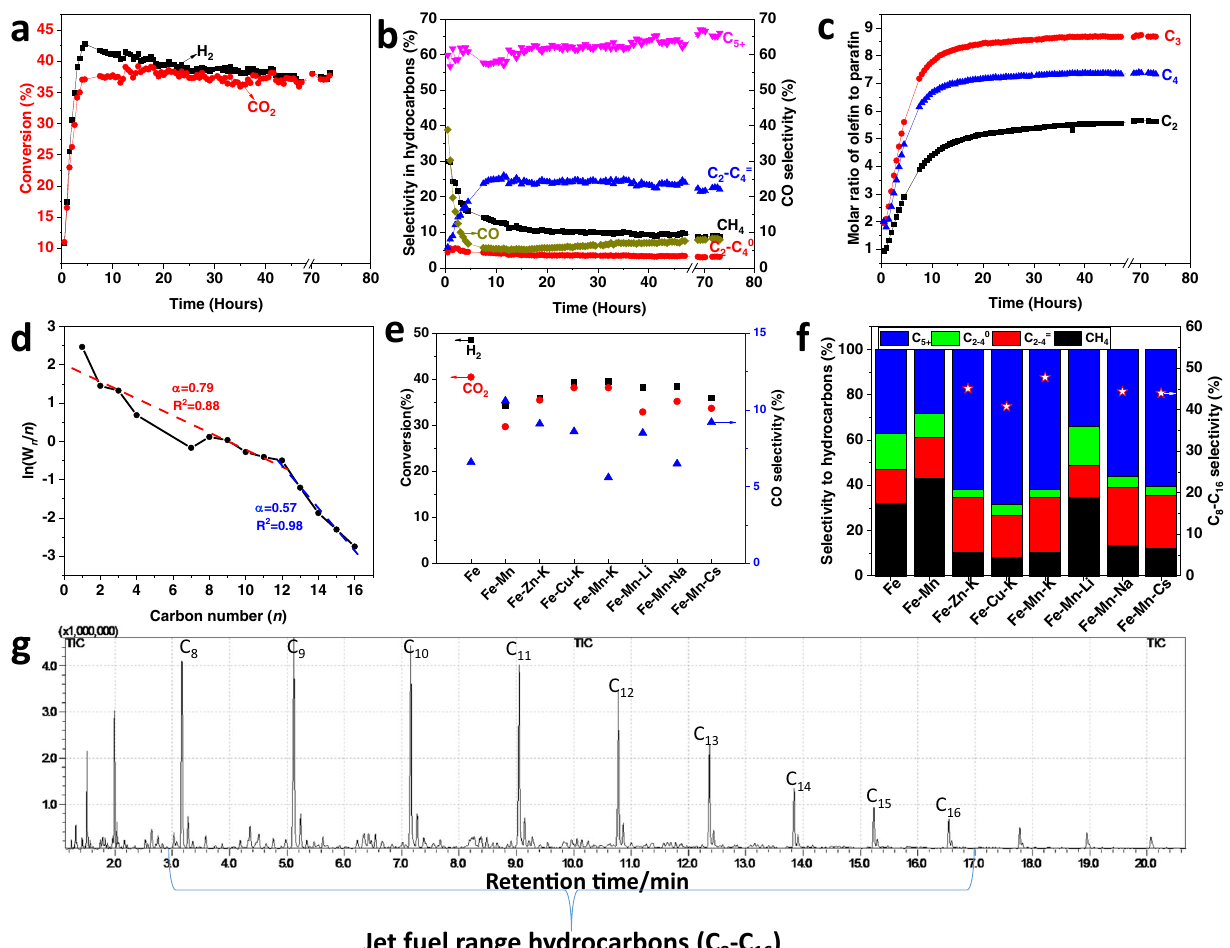
Fig. 1 Catalyst performance for the hydrogenation of CO 2 using a Fe – Mn – K catalyst. a % conversion of CO 2 and H 2 as a function of reaction time for the hydrogenation of CO 2. b Selectivity of various hydrocarbon products with reaction time for the hydrogenation of CO 2. c Molar ratio of ole fi n-to-paraf fi n for the C 2 – C 4 range with reaction time for the hydrogenation of CO 2. d ASF plot and α values at reaction time of 20 h. e Conversion and CO selectivity of CO 2 hydrogenation for a reaction time of 20 h over different catalysts. f Products selectivities of CO 2 hydrogenation for a reaction time of 20 h over different catalysts. g GC-MS total ion chromatogram (TIC) of the hydrocarbon fuel from the hydrogenation of CO 2 on a Fe – Mn – K catalyst. The jet fuel range hydrocarbons (C 8 to C 16 ) are